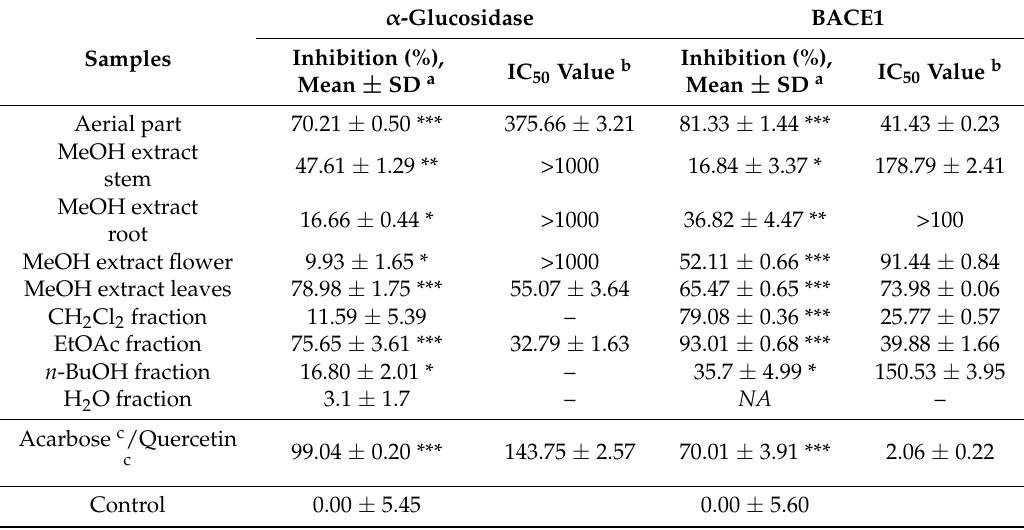
Table 1. α -Glucosidase and BACE1 inhibitory activity of MeOH extract of different parts and solvent-soluble fractions of leaves of C. maackii